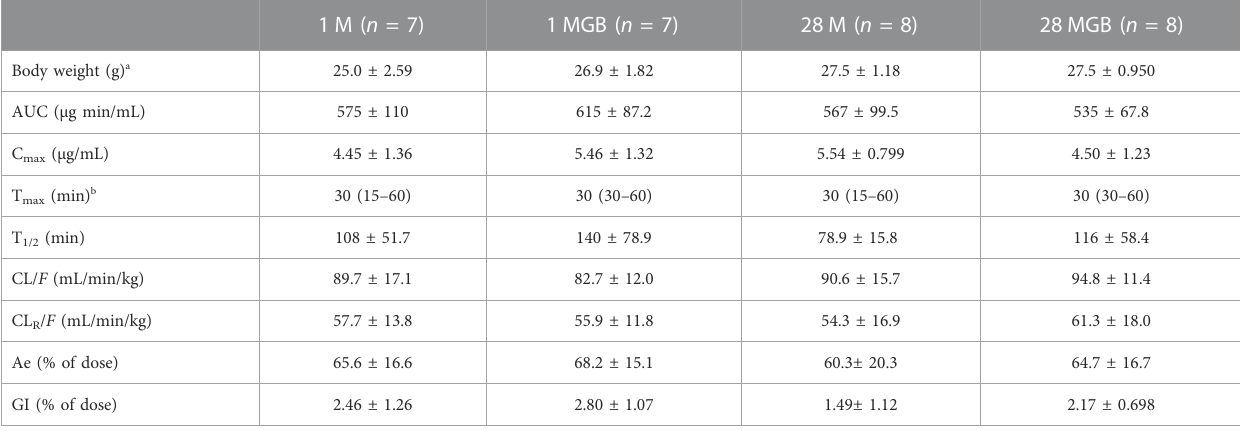
TABLE 1 Mean (±SD) pharmacokinetic parameters of metformin after its oral administration with or without GB in 1 M, 1 MGB, 28 M, and 28 MGB groups, respectively. The doses of metformin and GB were 50 and 200 mg/kg, respectively.